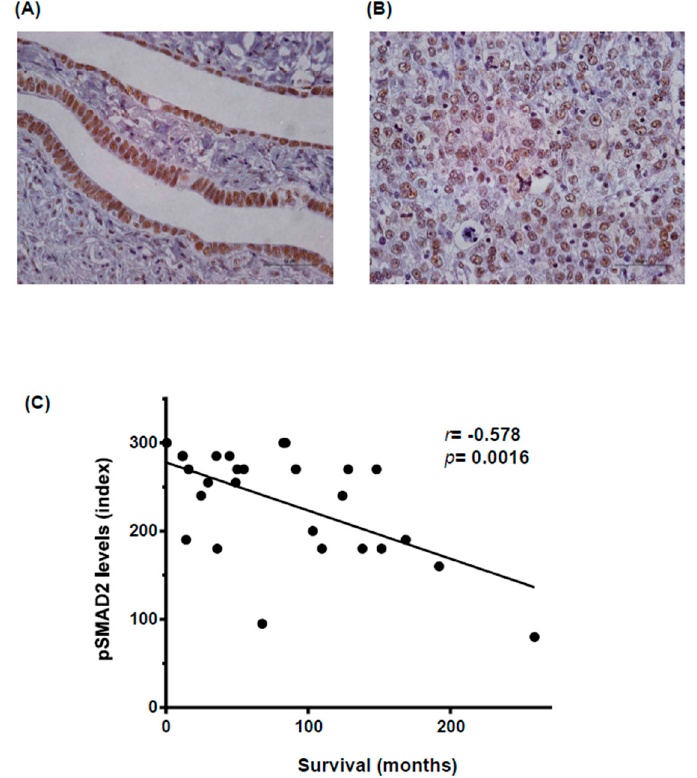
Figure 1. The level of phosphorylated and active SMAD2 (pSMAD2) staining is correlated with poor patient outcome. ( A ) pSMAD2 staining of normal human Fallopian tube epithelium. 400×, bar